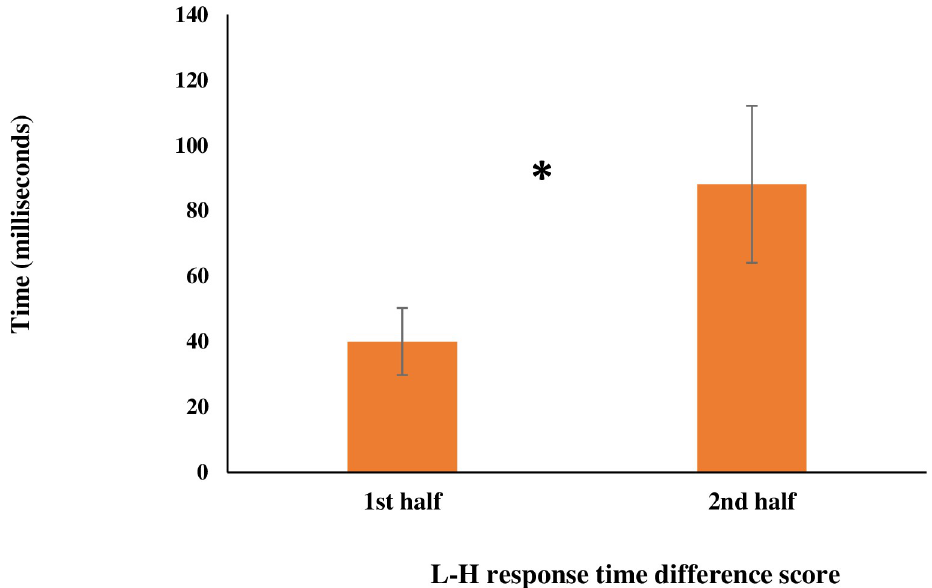
Fig 3. Behavioral change in learning. This figure shows change in RT (difference in response time between Low and High predictor conditions) from the first half to the second half of the statistical learning task. Error bars represent standard error